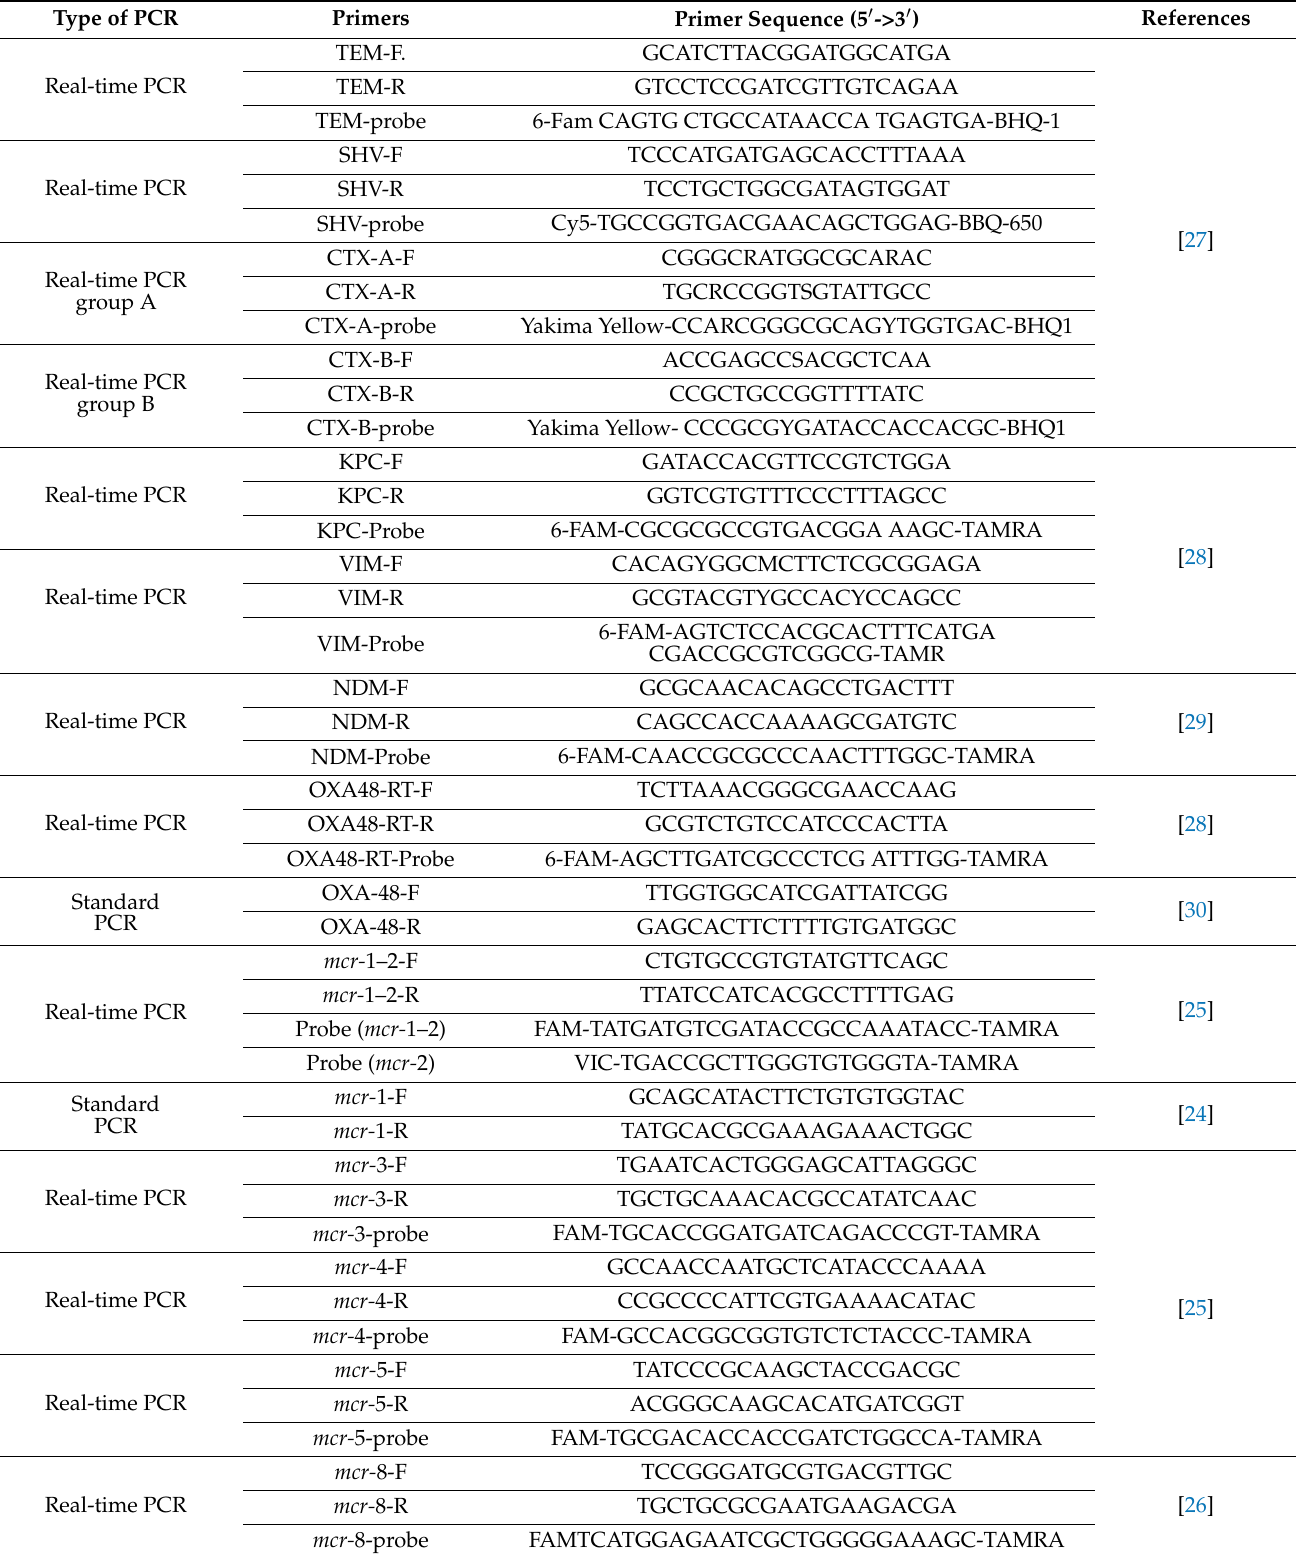
Table 1. Oligonucleotide primers and probes used for polymerase chain